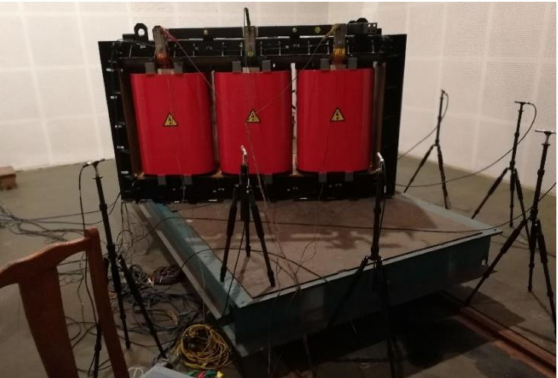
Figure 14. The test bench of vibroacoustic characteristic experiment of the